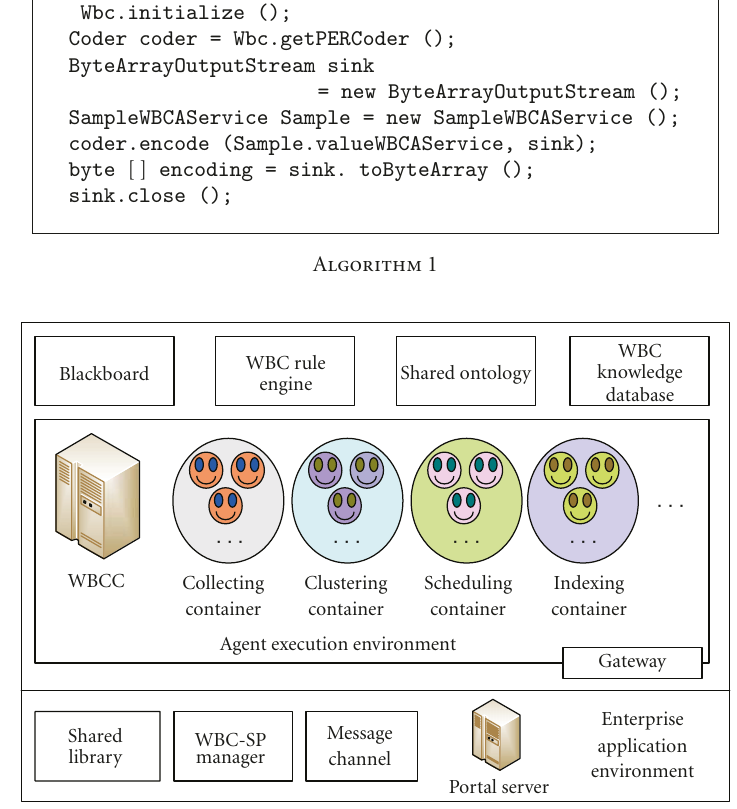
Figure 3: The WBC-SP agent execution environment and enterprise application